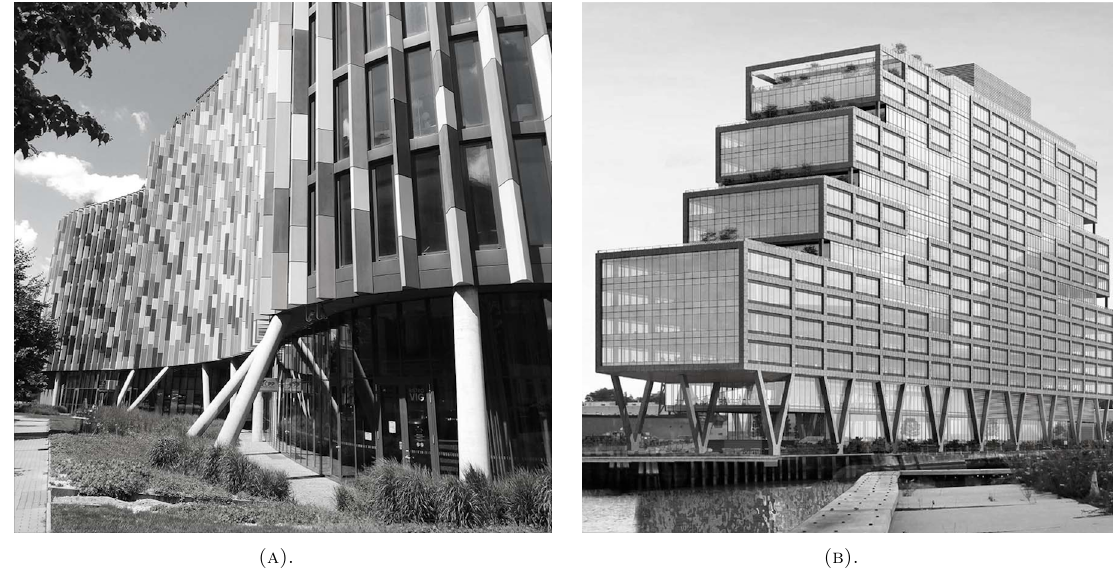
Figure 1. (A) Main Point Karlin, Prague (Czechia), designed by DAM Architeki. Details of the façade that works as sun shading. (B) Dock 72 at the Brooklyn Navy Yard (NYC), designed by S9